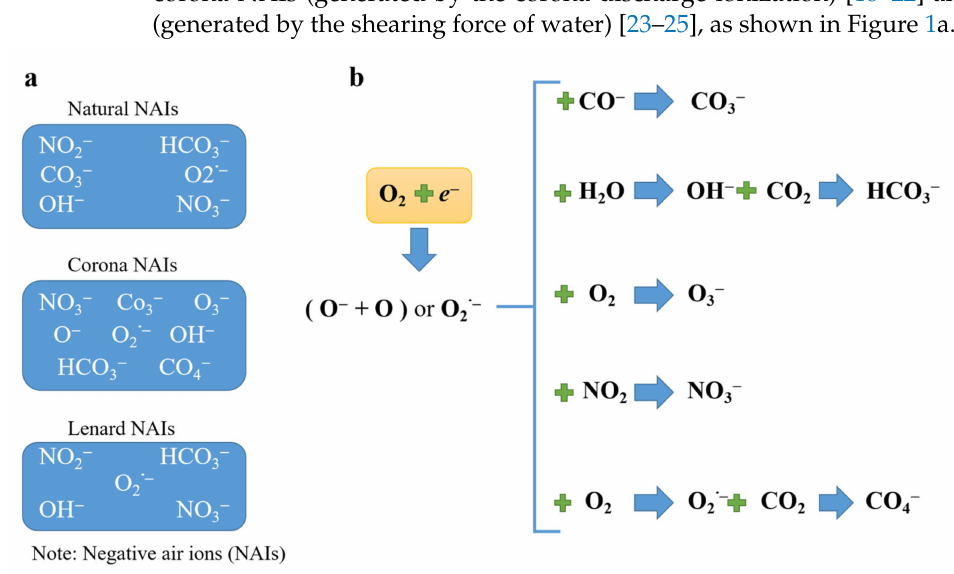
Figure 1. The types of NAIs generated through different ways through the oxygen − based ( a ) NAI compositions. ( b ) The evolution formula of NAIs. The blue arrows indicate the NAI transformation